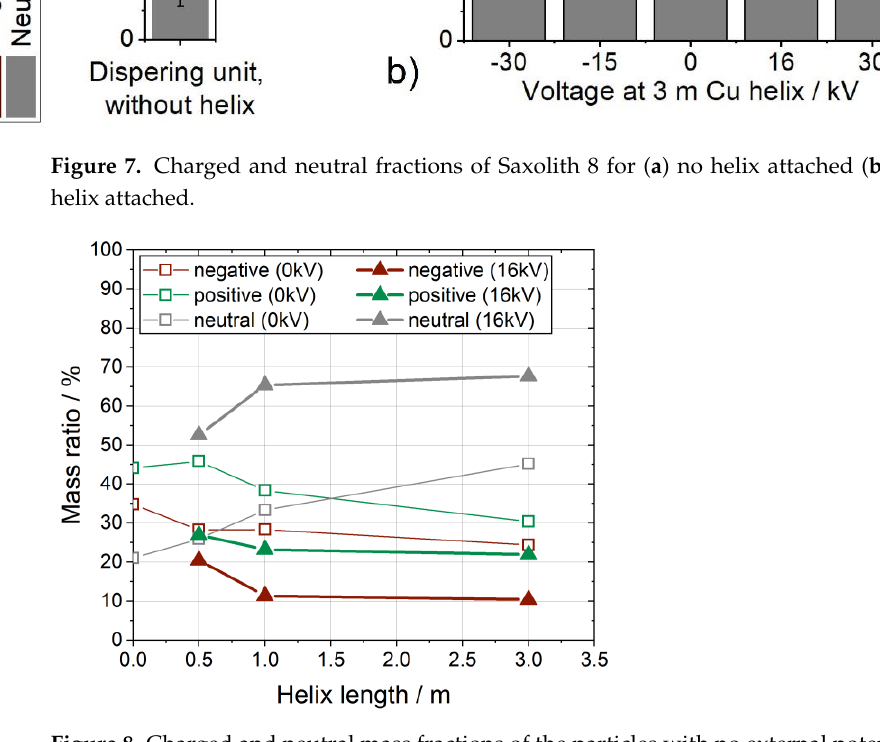
Figure 7. Charged and neutral fractions of Saxolith 8 for ( a ) no helix attached ( b ) a 3-m copper helix attached.